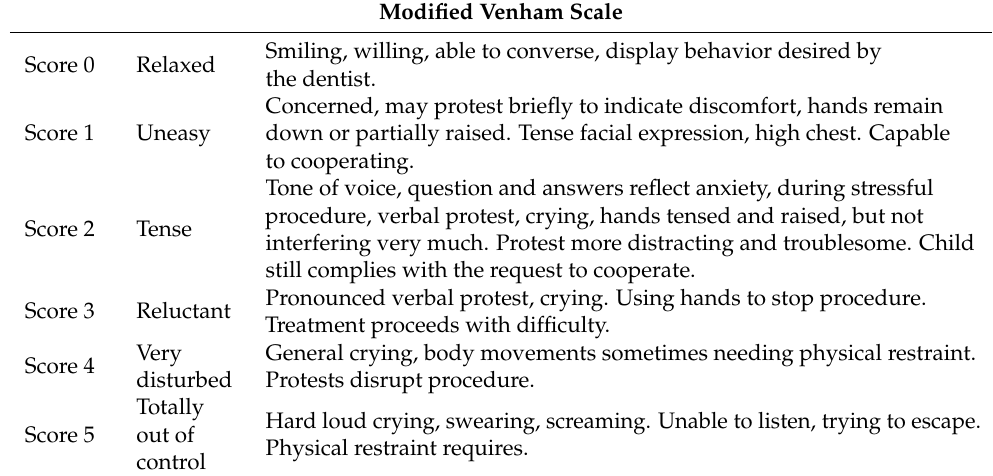
Table 1. Modified Venham scale.